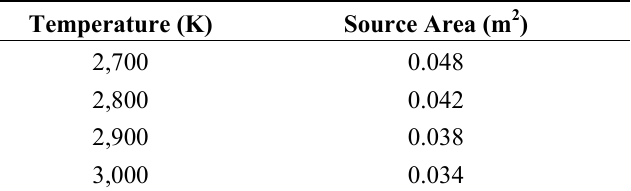
Figure 9. Plot of M13 vs. M12 radiances for Nightfire local maxima pixels from 4 April 2013. Across the upper tier of the chart there is a line of M12 saturated